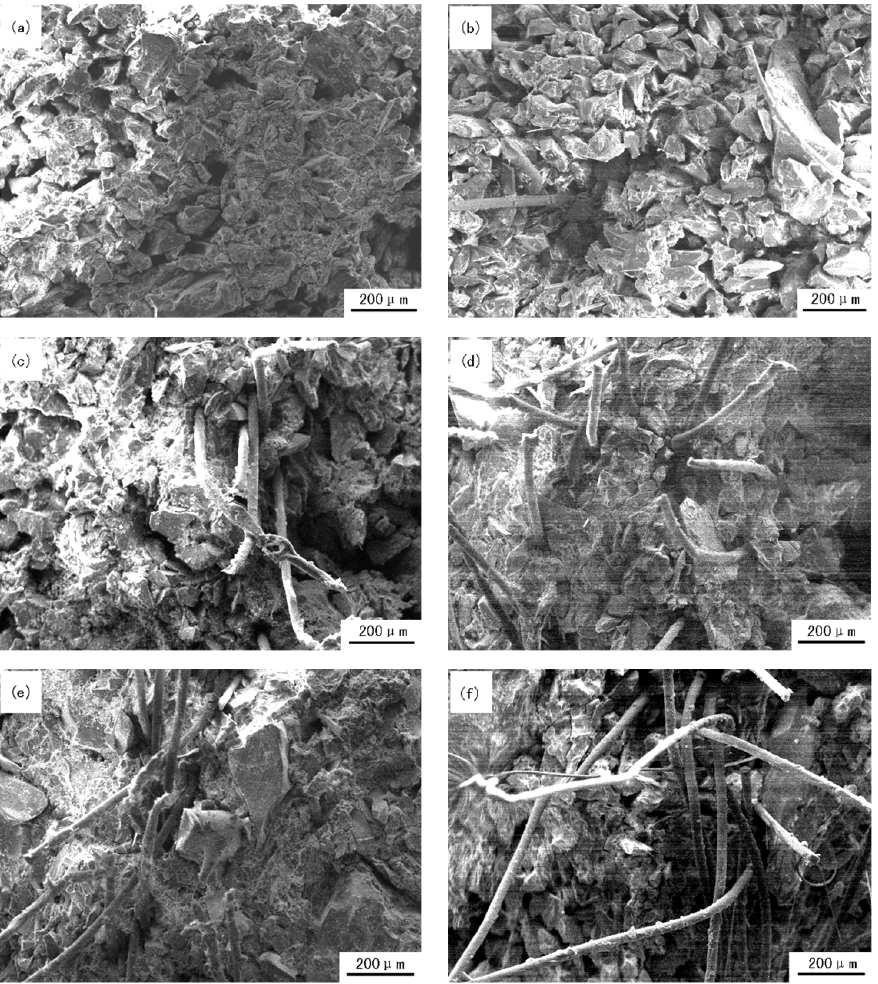
Figure 8. The distribution morphology of silica sol slurry shell with different fiber contents: ( a ) 0%; ( b ) 0.15%; ( c ) 0.3%; ( d ) 0.45%; ( e ) 0.6%; ( f ) 0.75%.